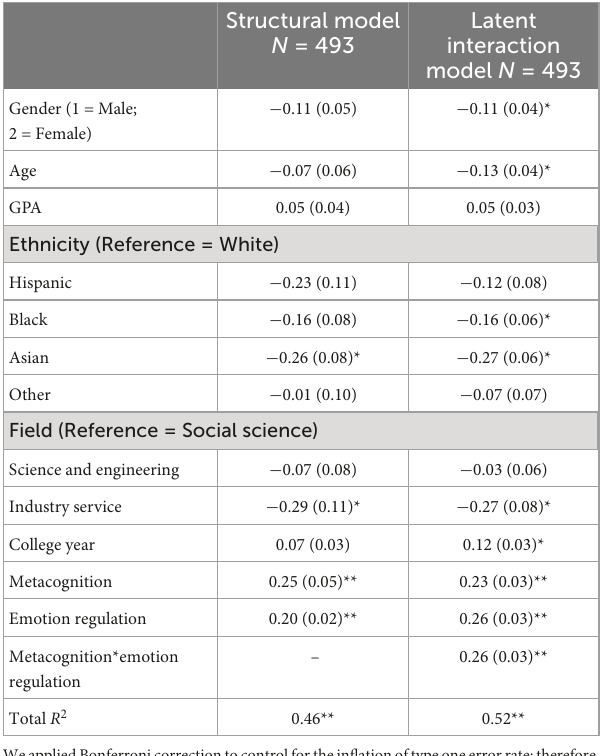
TABLE 3 Unstandardized path coefficients (and standard errors) of the latent interaction model predicting